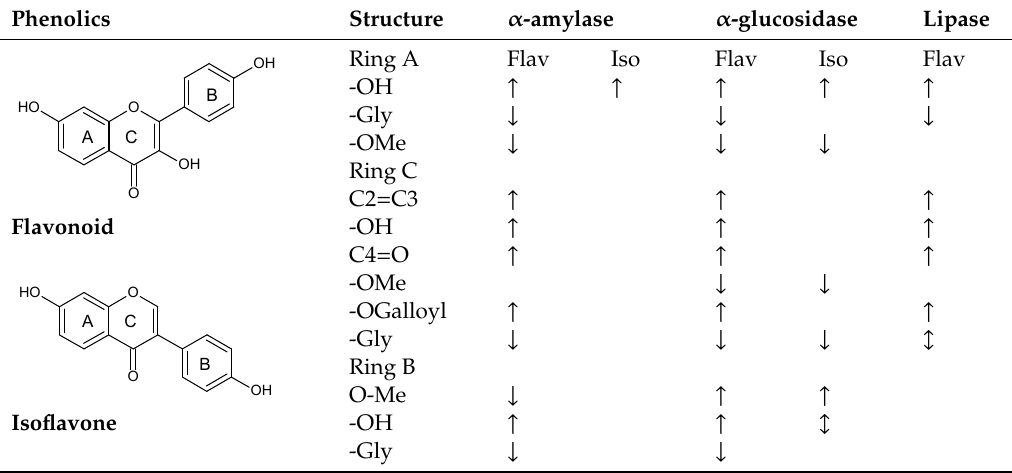
Table 8. Structure-activity relationship of flavonoids-digestive enzymes inhibition. Phenolics